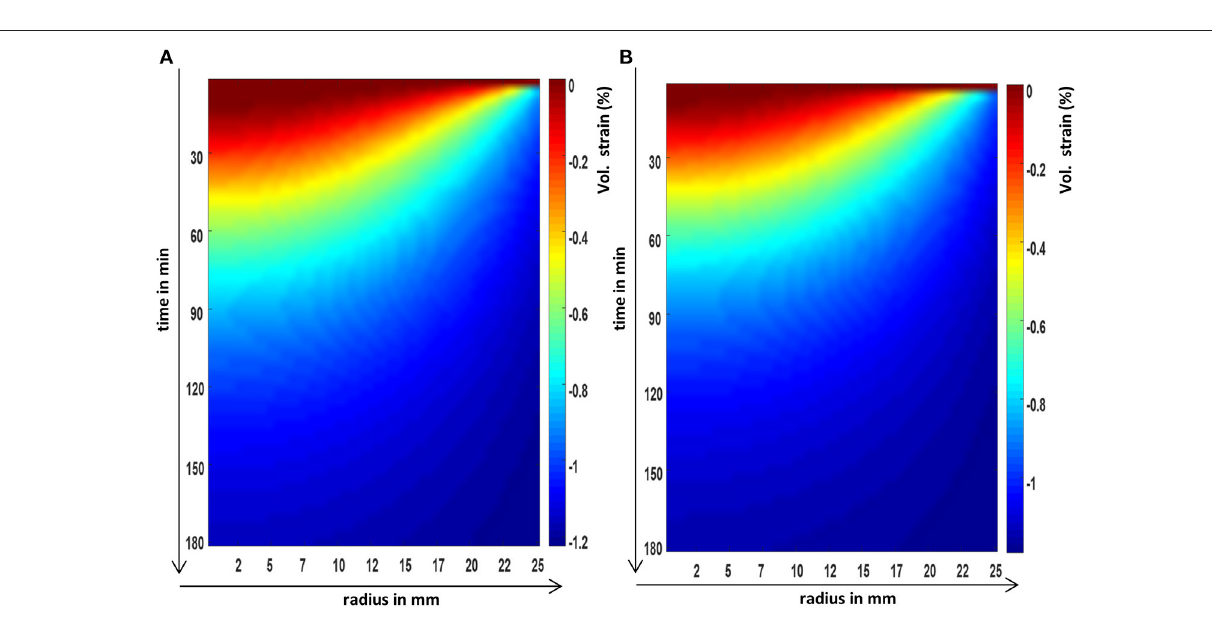
There is only one equation in which the parameters p 21